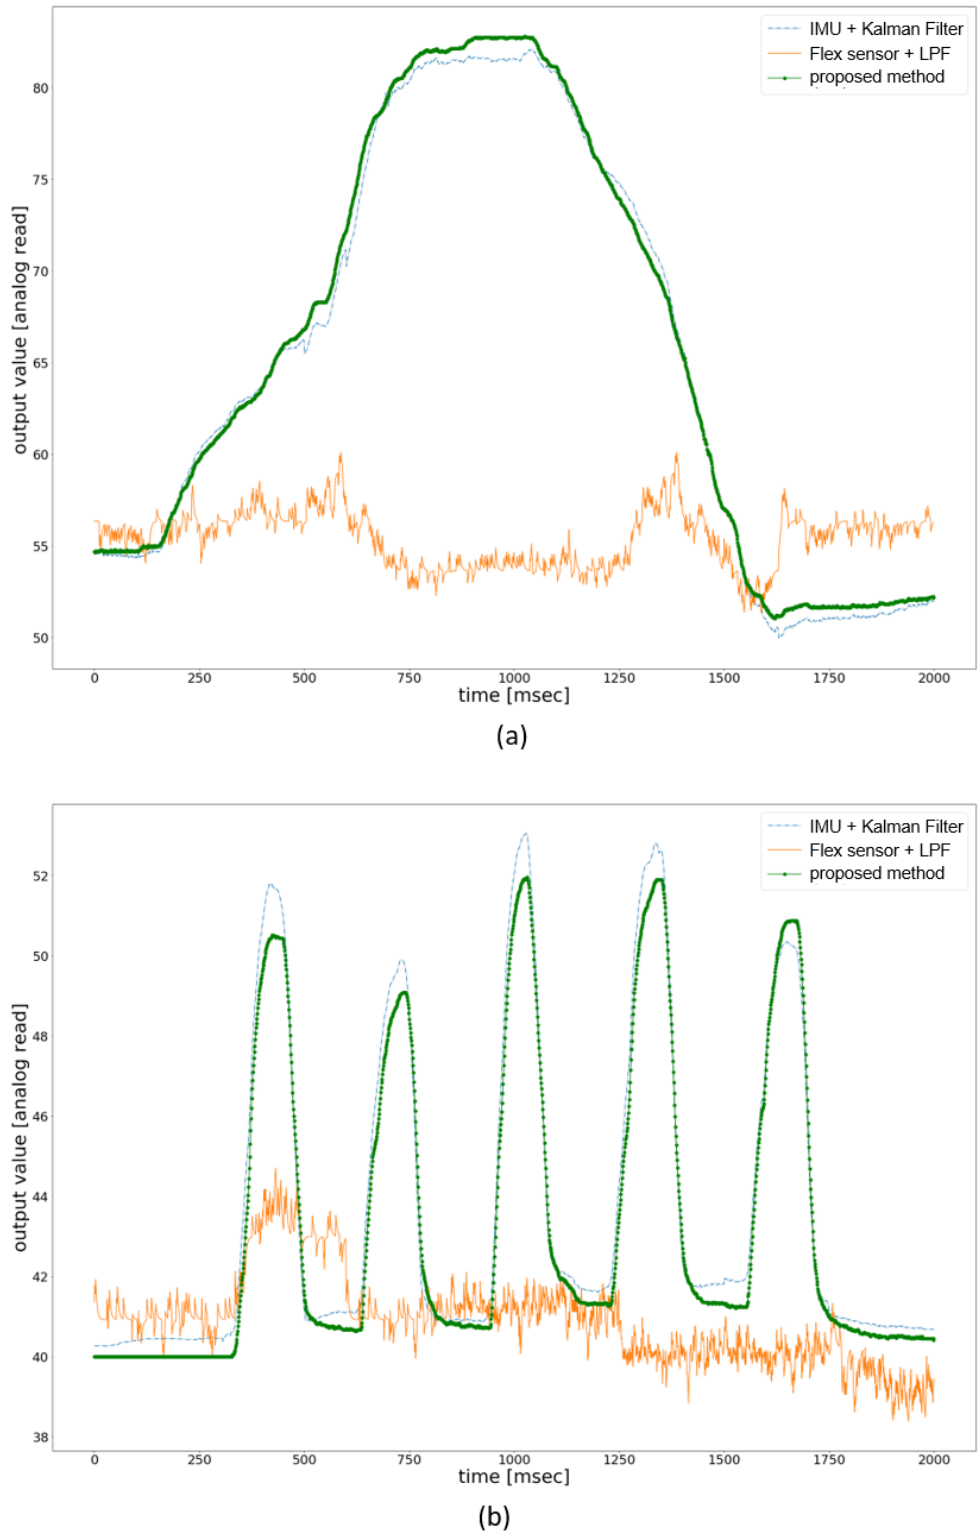
Figure 9. Comparison of the filtered adduction/abduction value in terms of noise reduction with method 1(IMU sensor + Kalman filter) and method 2(flex sensor + LPF). ( a ) noise-reduction com- parison for normal adduction/abduction movements. ( b ) noise-reduction comparison for fast adduction/abduction